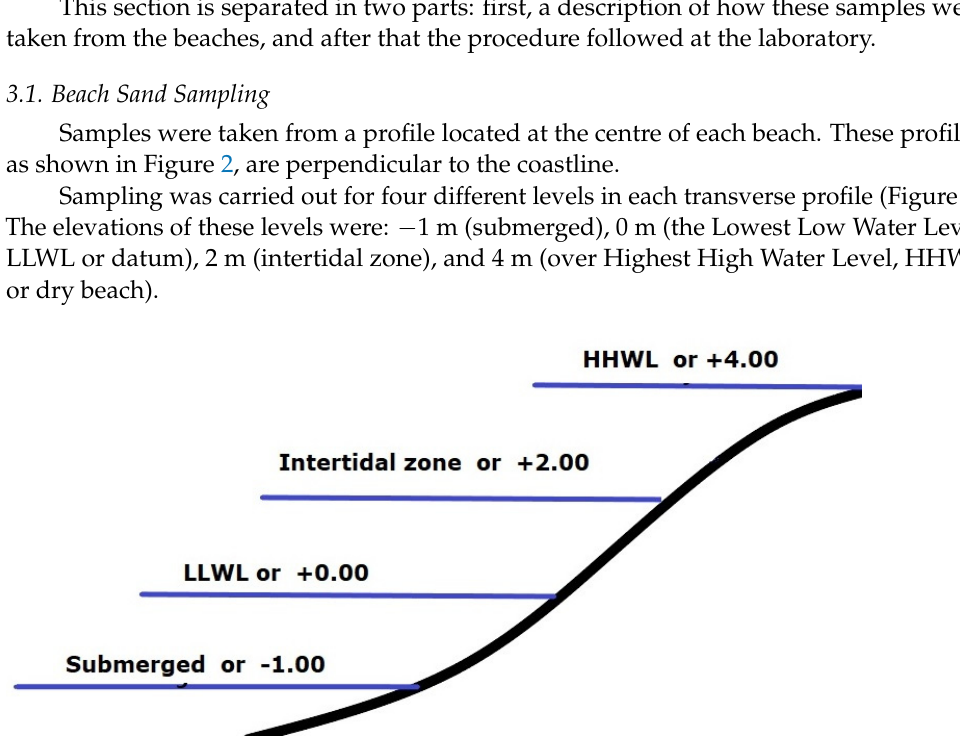
Figure 4. Different levels surveyed in each beach profile.